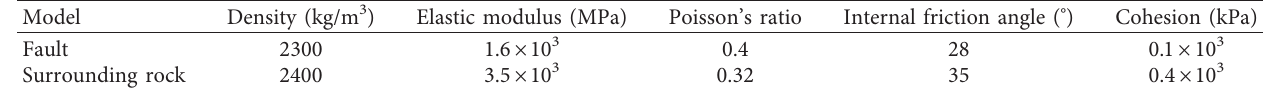
Table 2: Material parameters of surrounding rock and